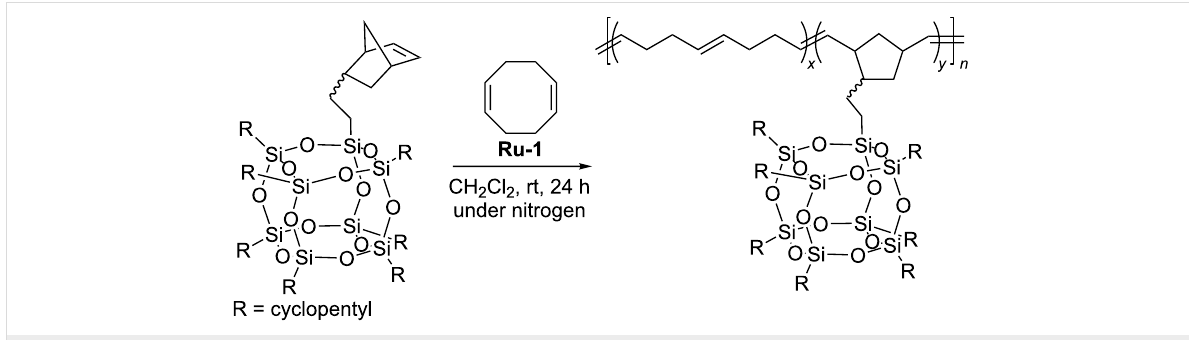
In the random copolymers obtained, the associative interactions between the particles were shown to result in the formation of ordered nanostructures. TEM micrographs indicate that the copolymers assemble into small, randomly oriented lamellae with lateral dimensions of approximately 50 nm and a thick- ness of ca 3–5 nm that corresponds to twice the diameter of a POSS nanoparticle. With increasing POSS concentration, the nanostructures extend to longer continuous lamellae having lateral lengths in the order of microns. Ruthenium alkylidene catalyst Ru-5 was successfully used in copolymerization of cubic silsesquioxane bearing four β -styryl and four (3-phenyl- oxiran-2-yl) substituents with dicyclopentadiene (DCPD) [45]. Moreover, octanorbornenyl cubic silsesquioxane was found to undergo ring-opening metathesis copolymerization with DCPD. Due to limited solubility only 0.1 mol % of POSS was used in the copolymerization. Such a small content of the POSS-con- taining comonomer caused, however, an increase in T g up to 15 °C in relation to that of polyDCPD. Similar examinations were reported by Coughlin who used first generation Grubbs catalyst ( Ru-1 ) for copolymerization of POSS-functionalized norbornene with DCPD (Scheme 23) [46]. During polymeriza- tion, PPh 3 had to be added to reduce the activity of Ru-1